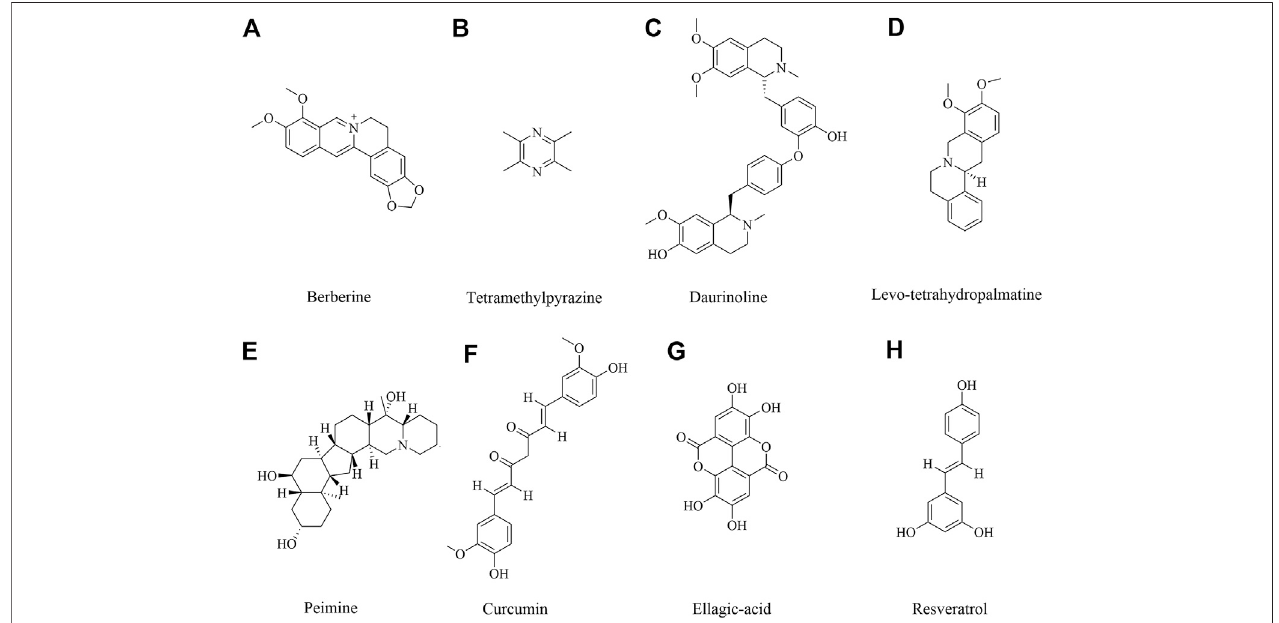
FIGURE 3 | The alkaloids, polyphenols and acids for cerebral ischemia